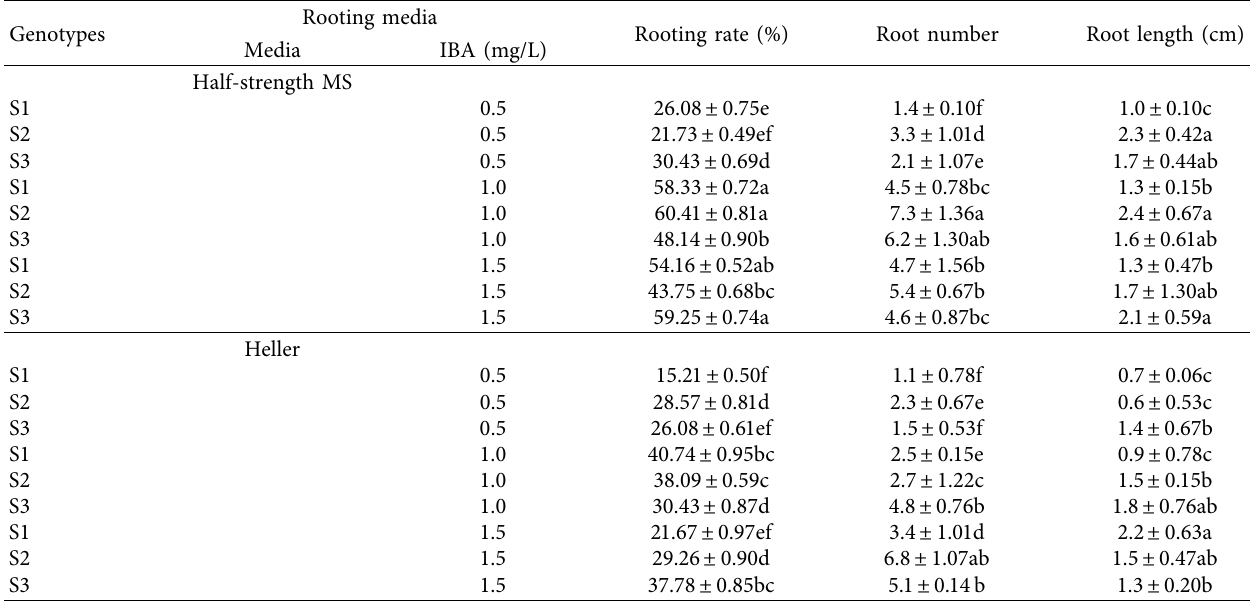
Table 4: Rooting average of the “Beldi” almond ecotypes on half-strength MS and Heller media with different concentrations of IBA.